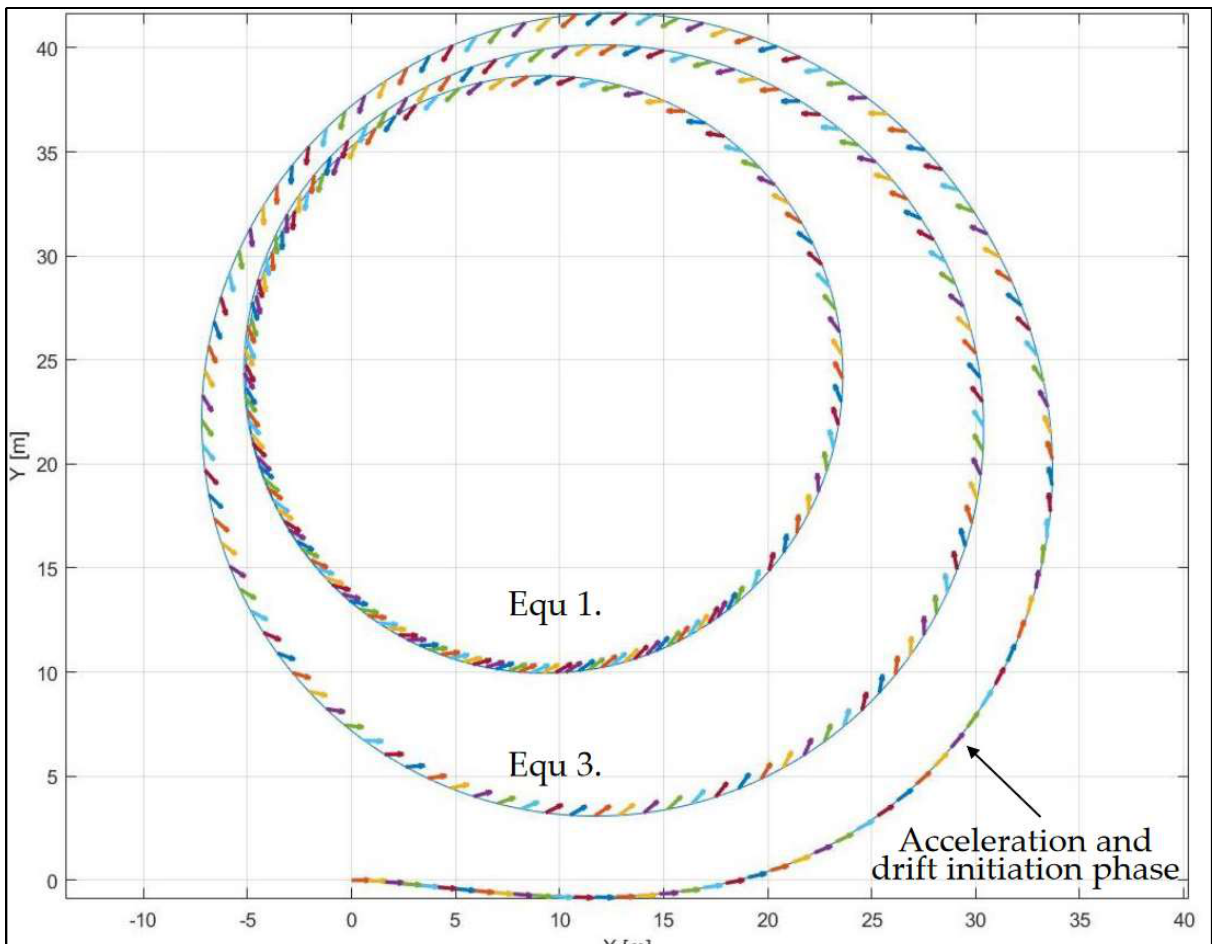
Figure 12. Path and heading of the vehicle in the changing road grip test case.